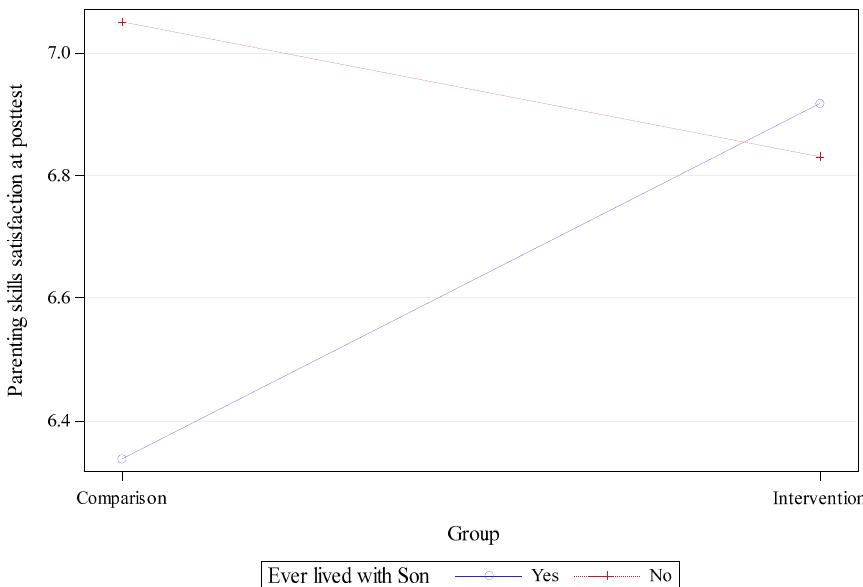
Figure 1. Residential history as a moderator of the Fathers and Sons intervention on parenting skills satisfaction at post-test among nonresident African American fathers. Note: Fit was computed at fathers aged 37.3 years old, ever lived mother, married/cohabitated, high school education level, employed, and pretest parenting satisfaction score of